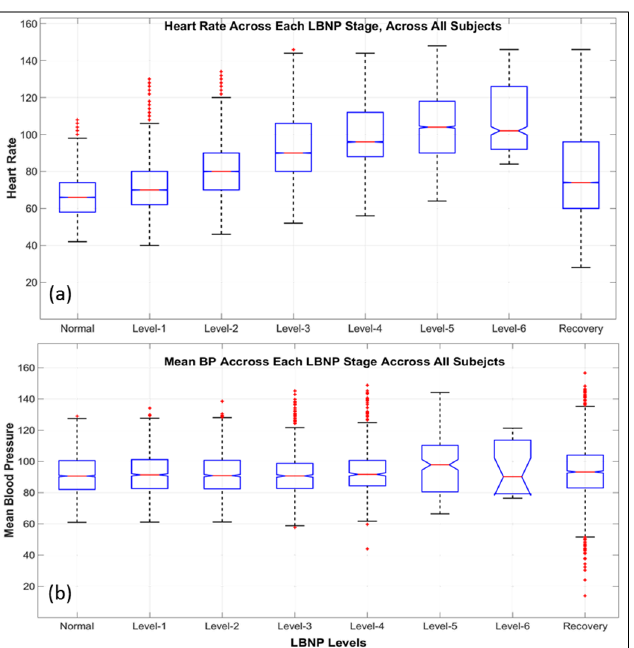
Fig 1. Heart Rate and Blood Pressure. The central mark within each box is the median, the edges of the box are the 25th and 75th percentiles, the whiskers are the standard deviations of the data at each stage and the outliers are plotted in red ‘ + ’ . (a): Box plot depicting the interpersonal variability of HR in each stage across all subject; (b): Box plot of overall mean and standard deviation of arterial BP across each stage of the LBNP